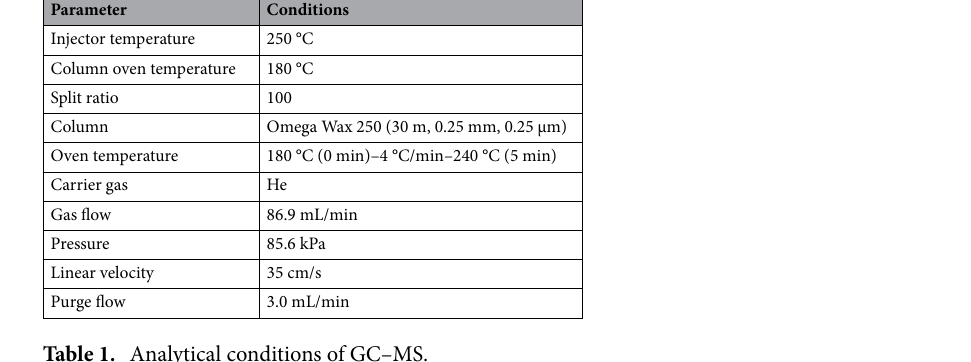
Table 1. Analytical conditions of